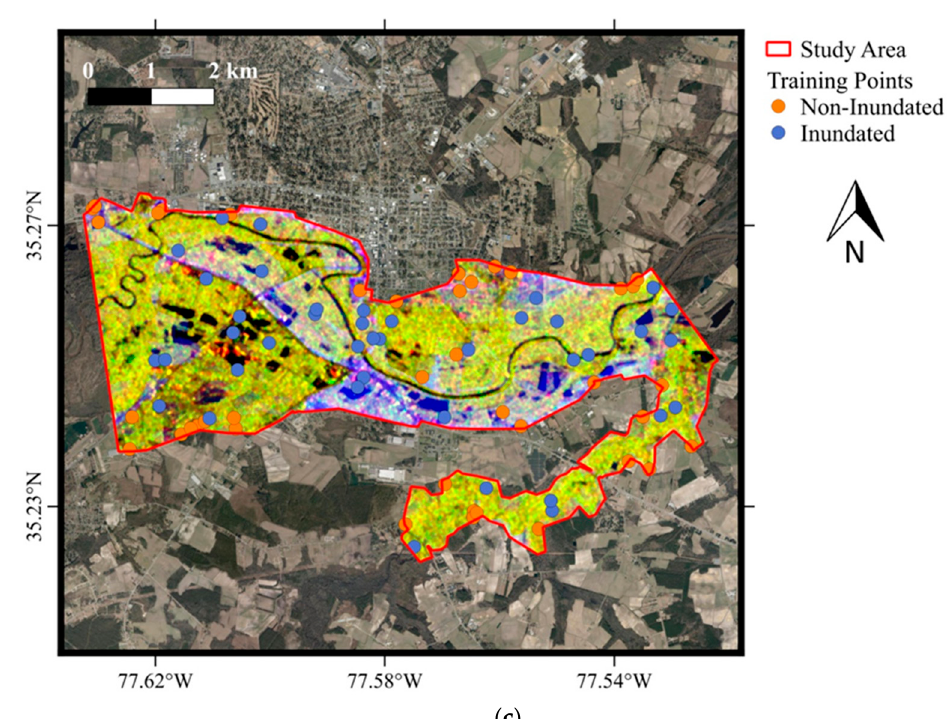
Figure 3. False color red, blue, and green (RGB) images representing vertical transmit (VV), vertical receive (VH), and height above nearest drainage (HAND), respectively, for the three study areas in ( a ), ( b ), and ( c ).